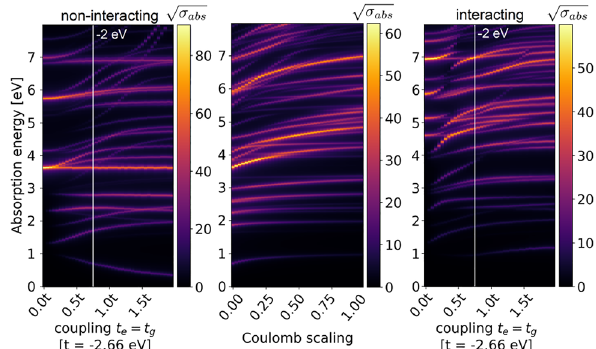
Figure 6: Optical absorption spectra for an 18-atom flake with an adatom having energy levels at E panel: Noninteracting spectra. Middle panel: Dependence of the spectrum on the Coulomb interaction strength for t Right: Interacting absorption